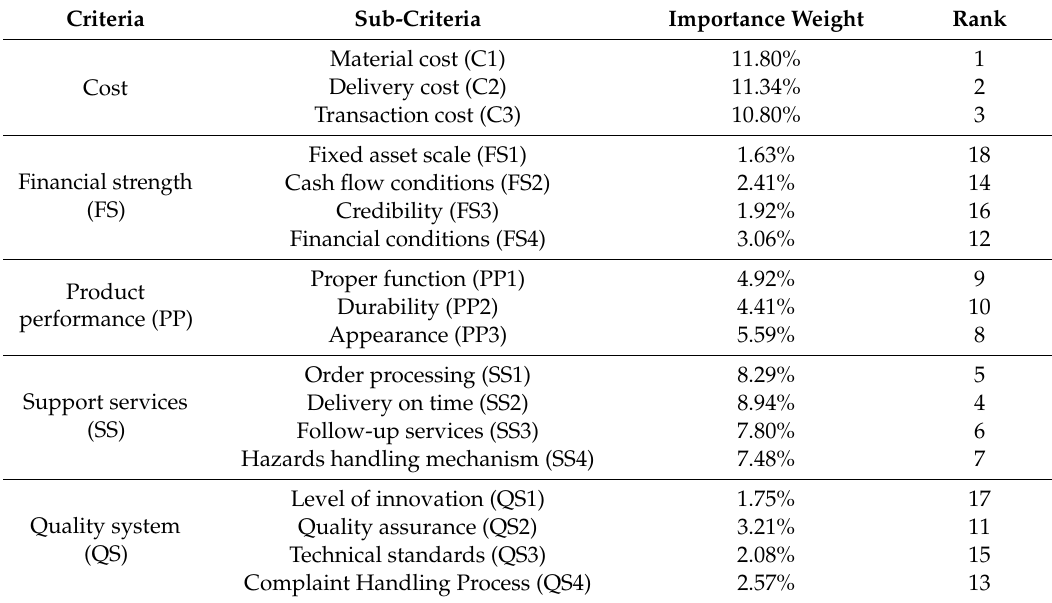
Table 4. The importance weights of the